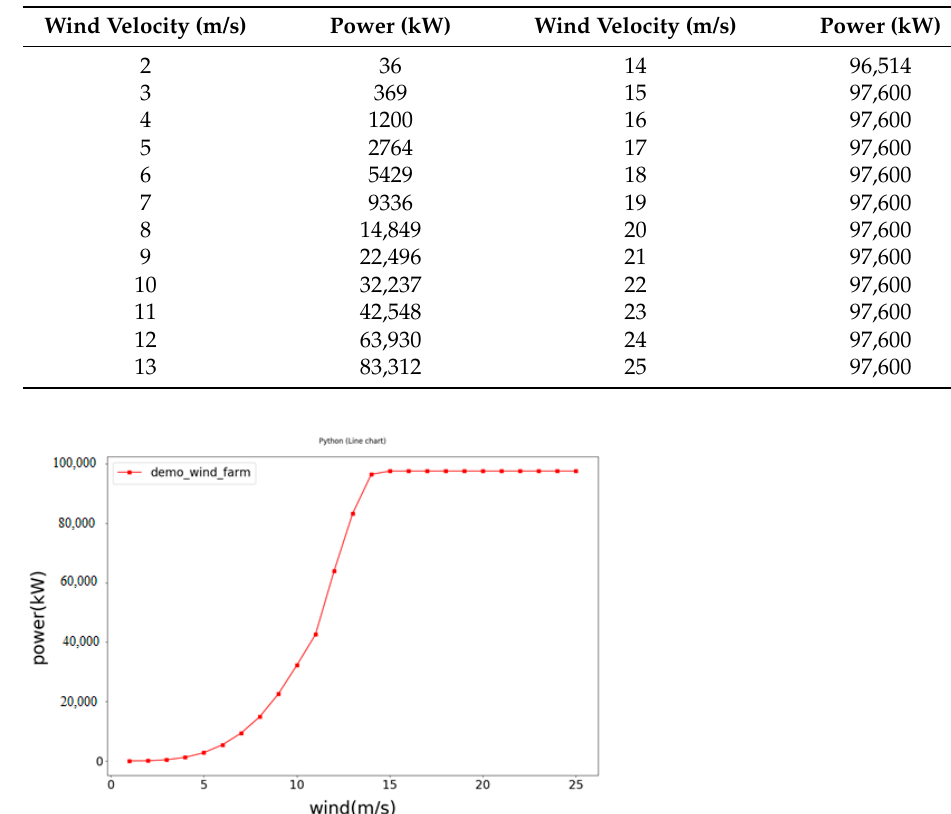
Figure 7. The demonstration windfarm of 32 turbines in 8 × 8 matrix in our real SINICA dataset. Table 3. Each wind turbine power at demonstration windfarm.